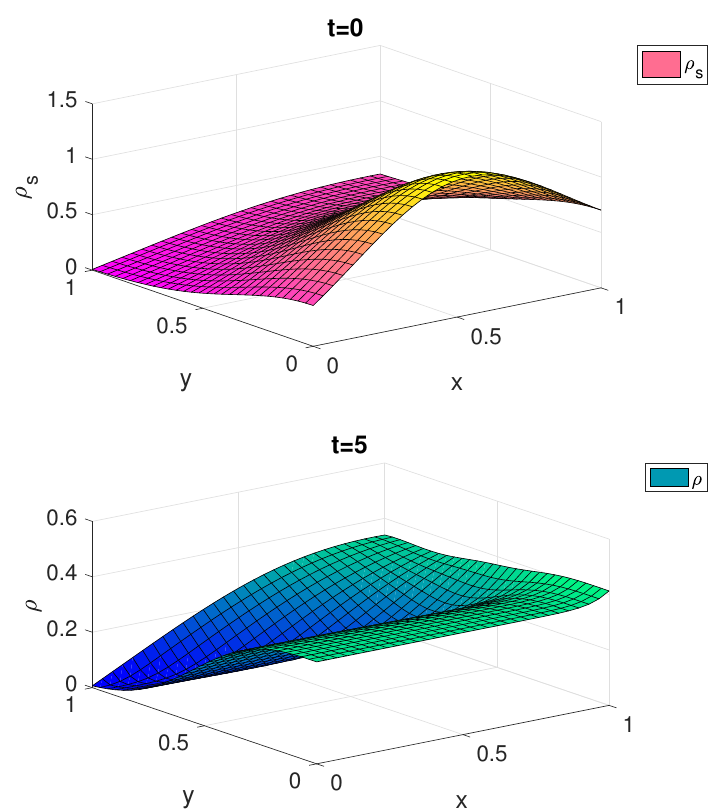
Figure 3. ρ s ( x , y ) and ρ ( x , y ,1 ) in the case (B1).